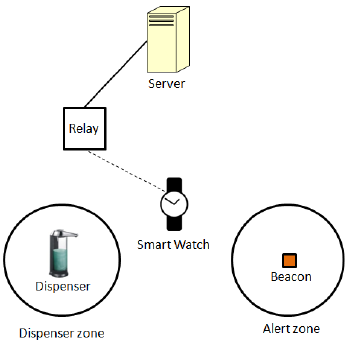
Figure 2: Components of Harmony